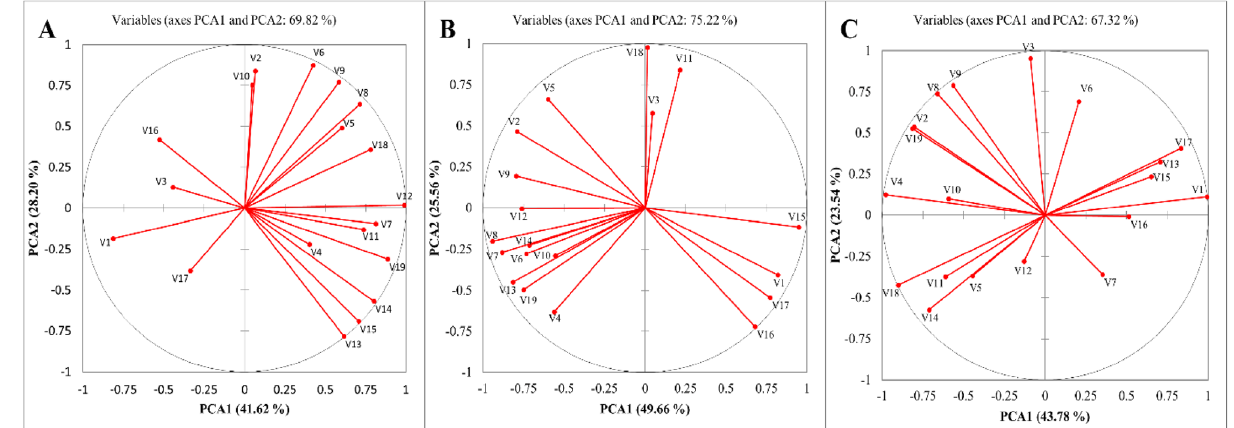
Figure 5. Vector graphs show the relative “contribution” of each input variable to the formation of the principal components. Principle component biplot based on variations of five levels of light spectra under ( A ) control (non-stress); ( B ) salinity stress; ( C ) alkalinity stress. Principal component analysis and biplots were performed using XLSTAT software version 2015. V1: Na leaves; V2: Fe leaves: V3: K leaves; V4: Ca leaves; V5: Mg leaves; V6: Inflorescence; V7: Early yield; V8: Fruit number; V9: Soluble solids; V10: a; V11: Hue; V12: Leaf dry weight; V13: Root dry weight; V14: Green leaves; V15: Chlorotic leaves; V16: Tip burned leaves; V17: Dry leaves; V18: SPAD; V19: